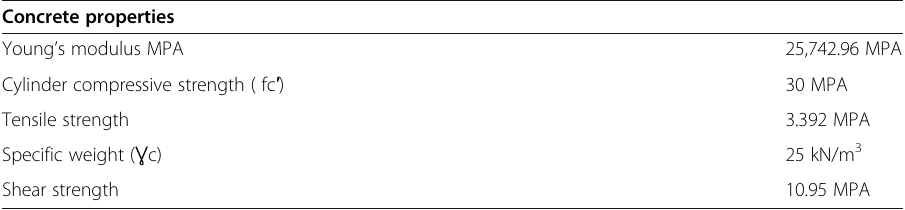
Table 5 Reinforcement steel properties Concrete properties